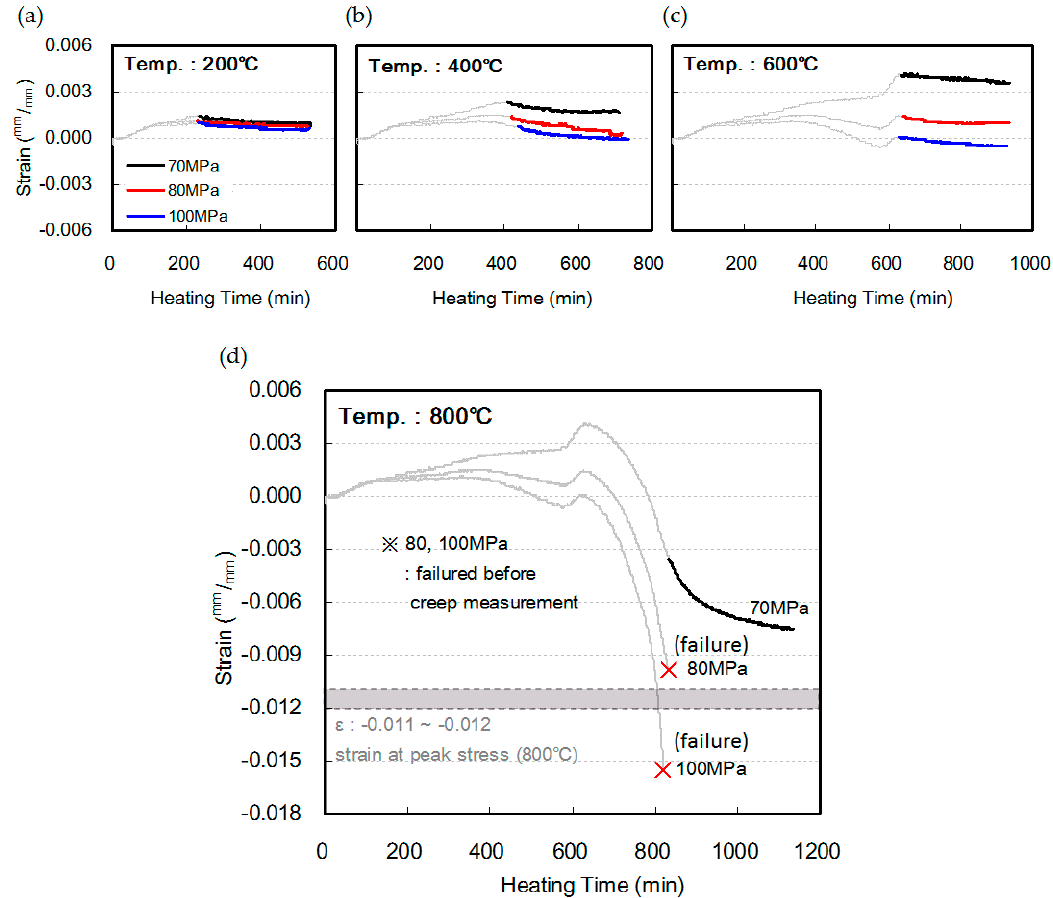
◦ C; ( b ) 400 ◦ C; ( c ) 600 ◦ C; ( d ) 800 ◦